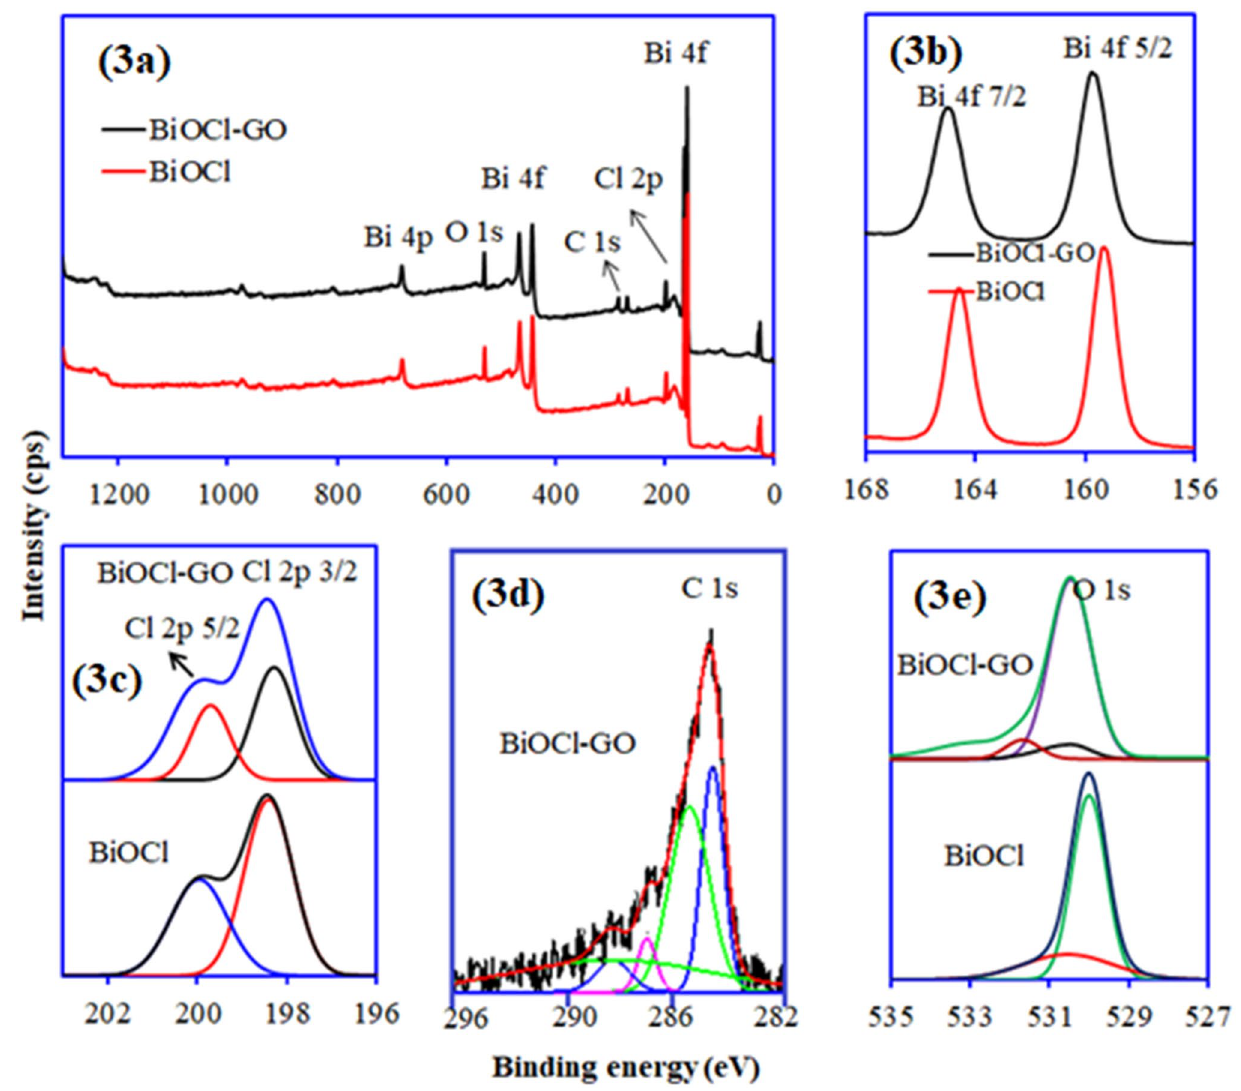
Figure 3. XPS analysis of BiOCl and BiOCl/GO composite ( a ) wide scan survey and deconvoluted spectra for ( b ) Bi 4 f (c) Cl 2 p , ( d ) C 1 s and ( e ) O 1